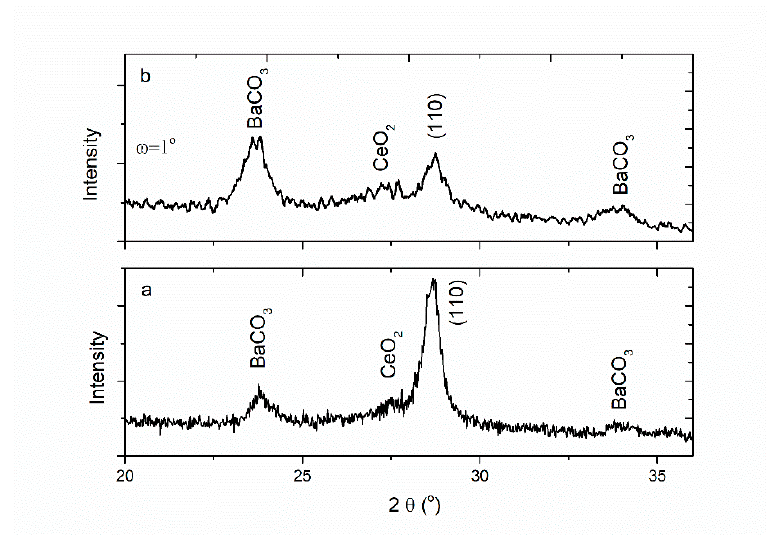
Figure 10. XRD patterns of the BCO films deposited on Inconel carried out after the Impedance Spectroscopy measurements. The patterns were obtained as ( a ) a typical θ - θ scan and ( b ) a grazing incidence scan.